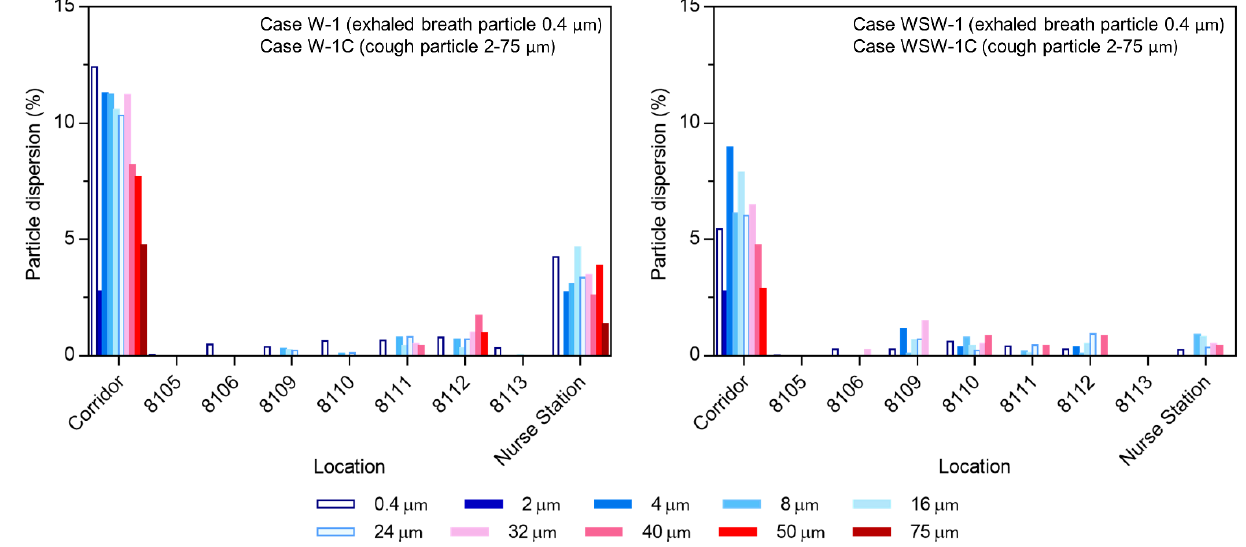
Figure 7. Particle dispersion rate with different wind directions.